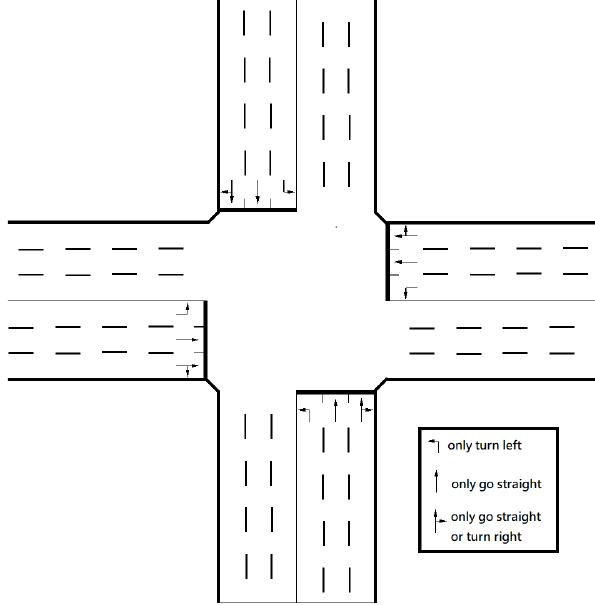
Figure 8. Intersection model used in our